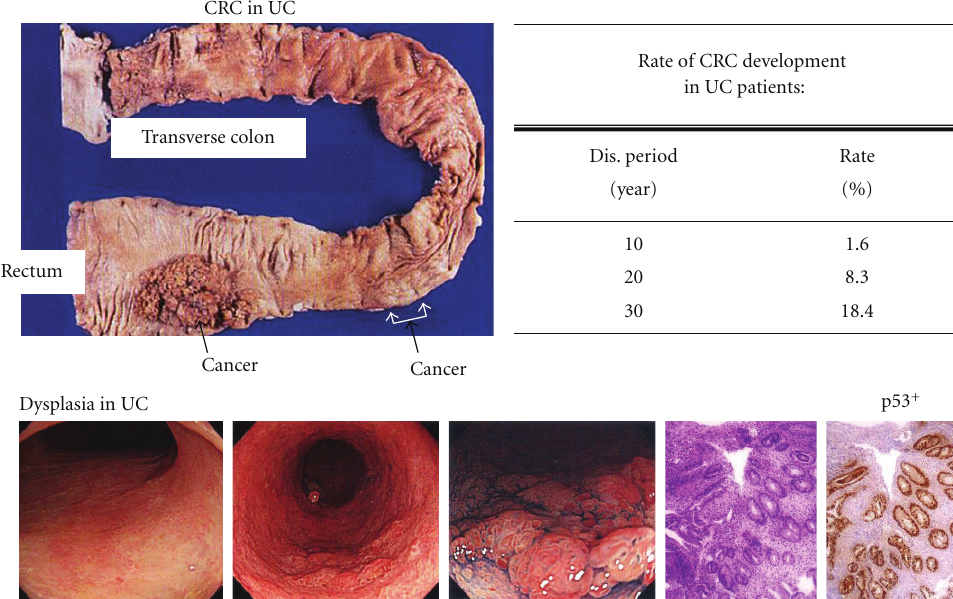
Figure 1: UC patients are high-risk groups of colorectal cancer (CRC) development.